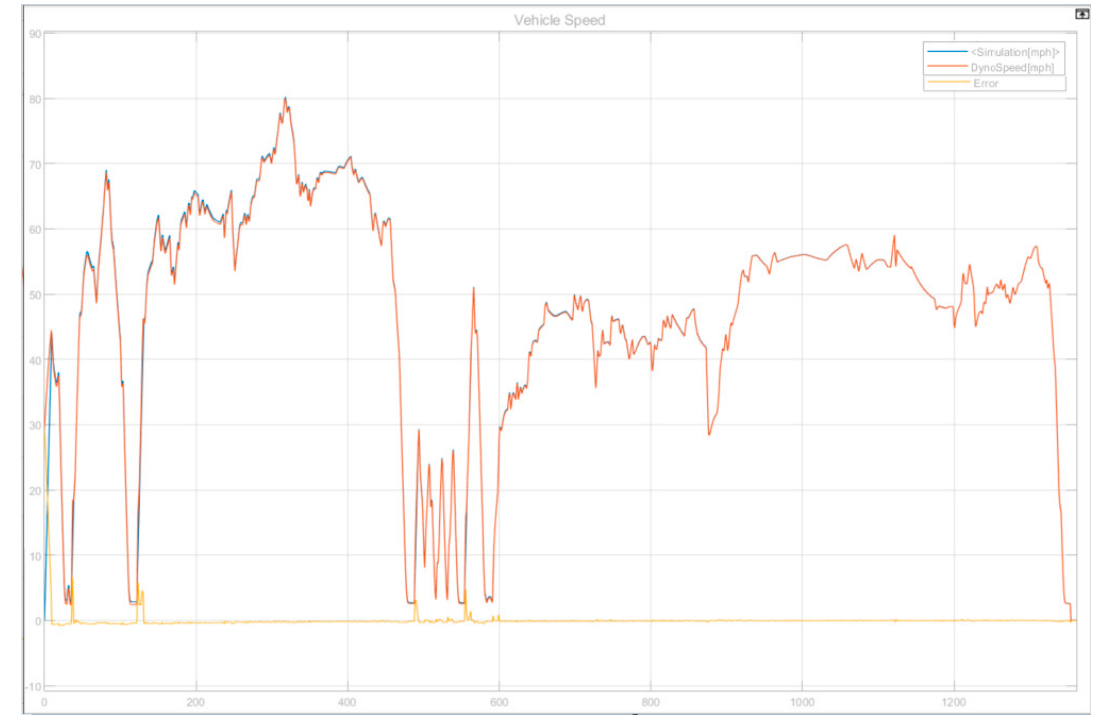
Figure 20. Modeled vehicle speed (mph) over time (secs) compared to dyno drive cycle speed.